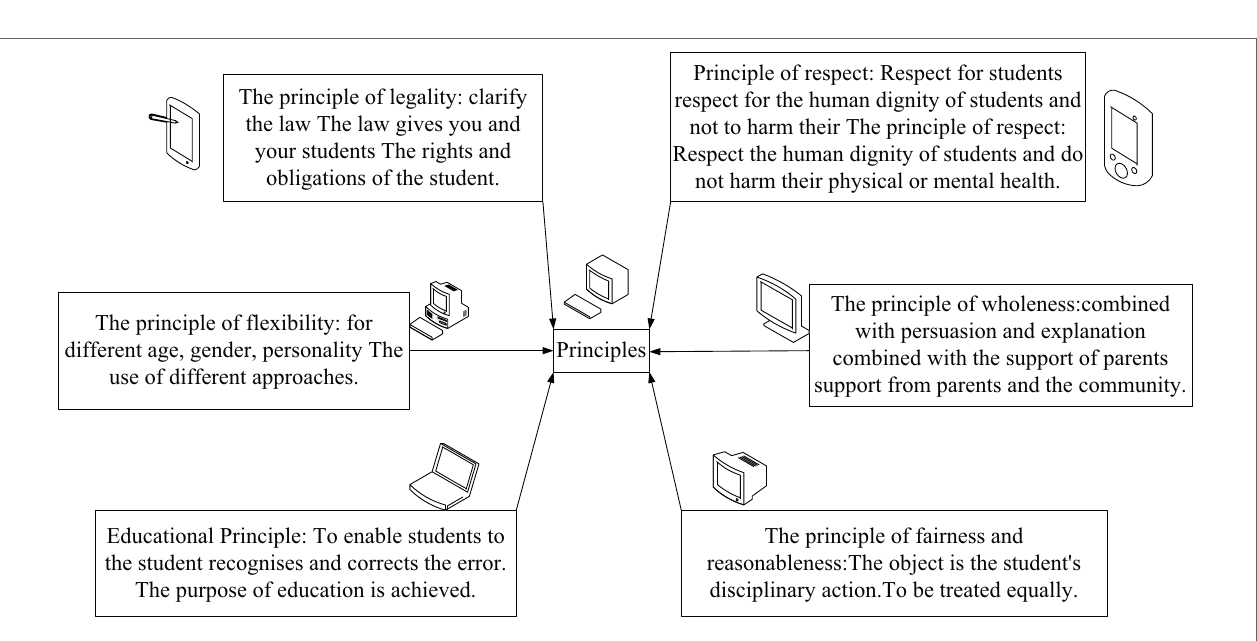
FIGURE 4 | Principles for the exercise of teachers’ disciplinary